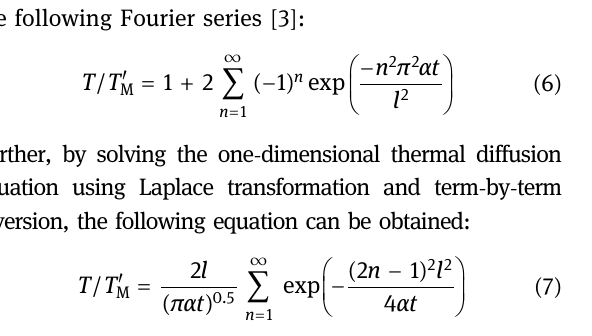
Figure 2: Normalized theoretical temperature - response curves in the T / T M range from 0.3 to 0.6: ( a ) plot of =